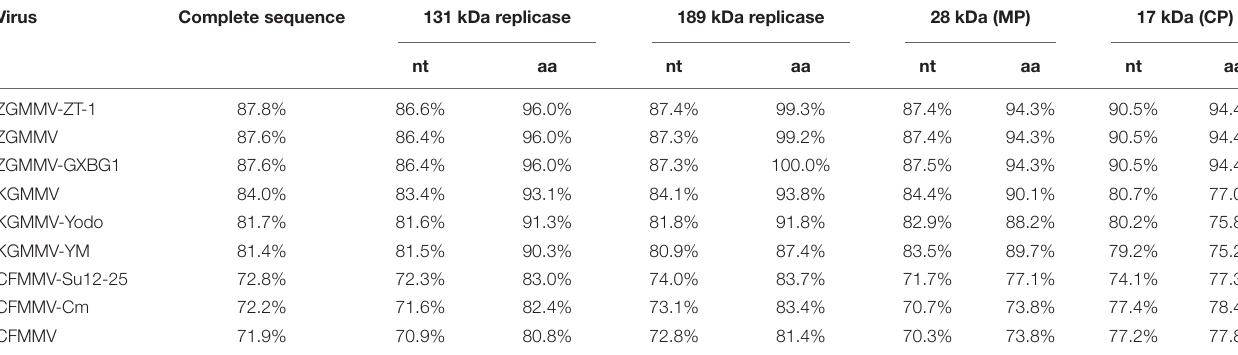
TABLE 1 | Percentage of nucleotide (nt) and amino acid (aa) sequence identities of Trichosanthes mottle mosaic virus to other nine tobamoviruses. Virus Complete sequence 131 kDa replicase 189 kDa replicase